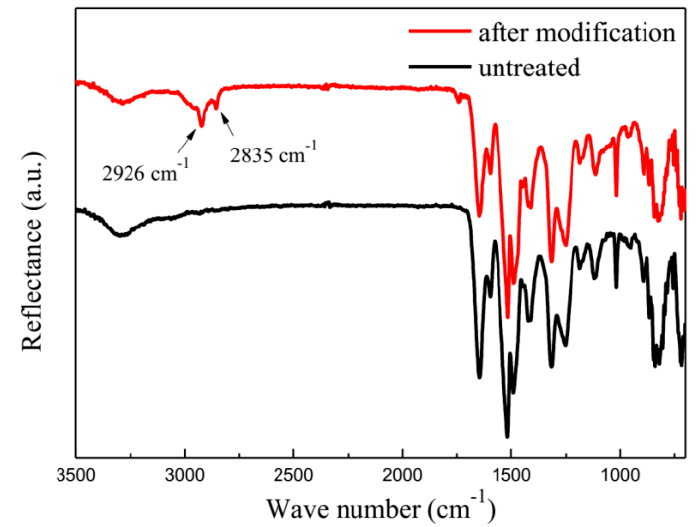
Figure 3. FTIR spectra of the aramid fiber before and after the modification of sample 2 in Table 1.